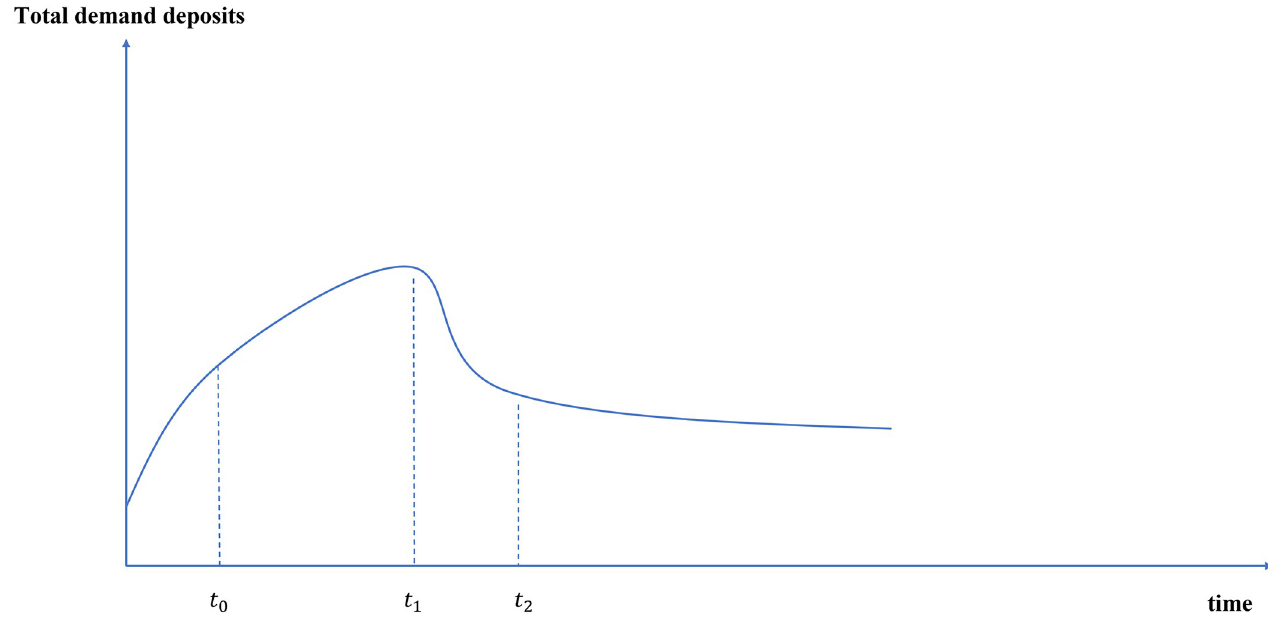
Fig 6. Path changes of demand deposit path after e-CNY issuance.